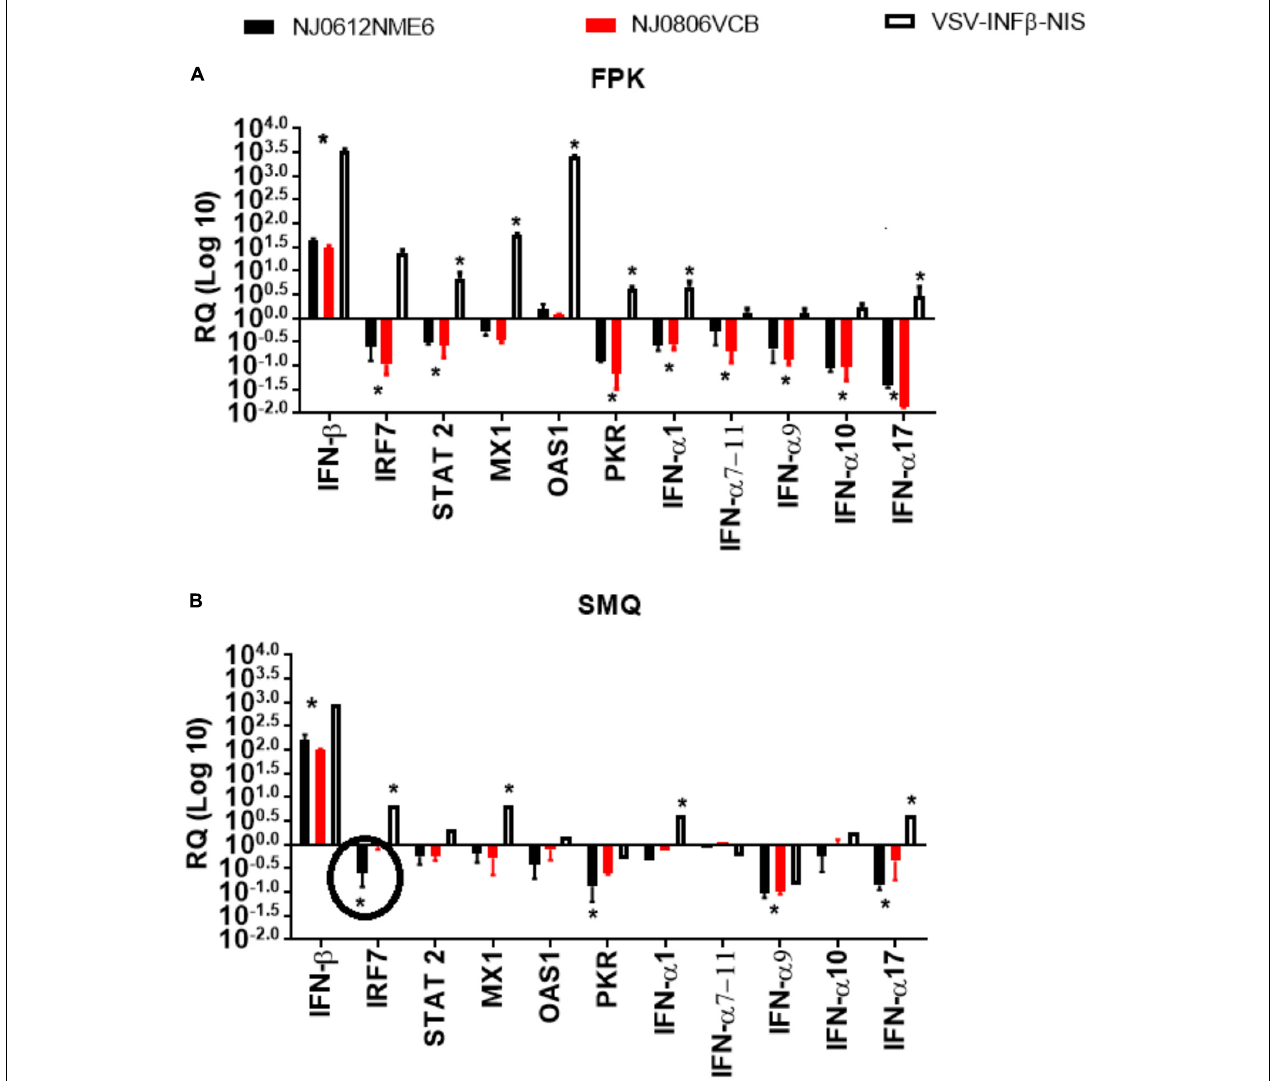
FIGURE 5 | Transcriptional regulation of the immune response. Changes in gene expression measured by rRT-PCR were determined in (A) fetal porcine kidney cells (FPK) and (B) porcine macrophage cells (SMQ). VSV-INF β -NIS was used as a positive control. Values are represented as relative quantities (RQs) of mRNA accumulation (estimated by 2 − (cid:49)(cid:49) C T ) with their corresponding SD. RQ values were considered significant when they departed from the corresponding level in uninfected cells by at least threefold in either direction. Asterisks represent significant values in one of the three viruses, and circles were used to represent significant differences between NJ0612NME6 and